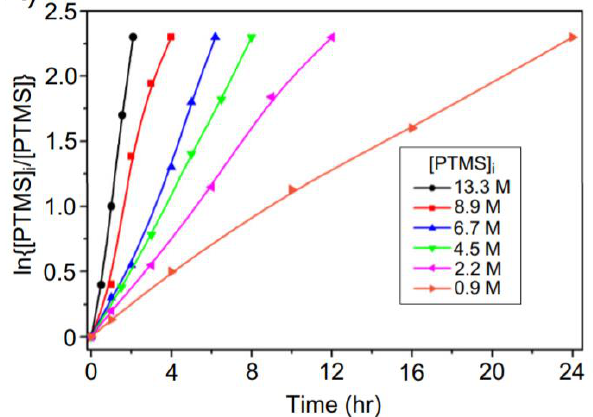
Figure 11. Kinetic rate plots for various [PTMS] i , [H 2 O] = 30 M, at 25 °C. Reprinted with permission from [29]. Copyright Elsevier, 2016.